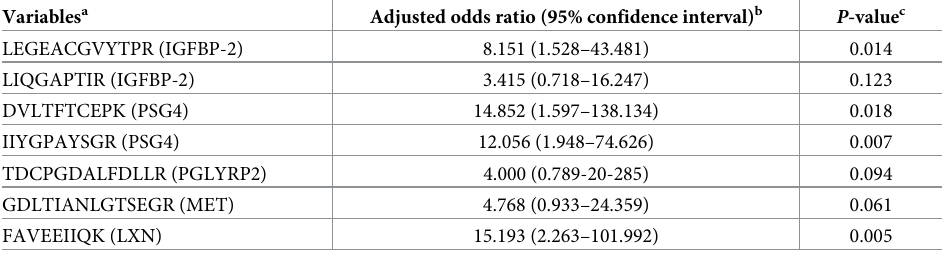
peptidoglycan recognition proteins 2; MET, hepatocyte growth factor receptor; LXN, latexin. a All continuous predictors were entered as dichotomous variables using the cut-off values derived from the receiver- operating characteristic curves to predict SPTD at < 33 weeks.